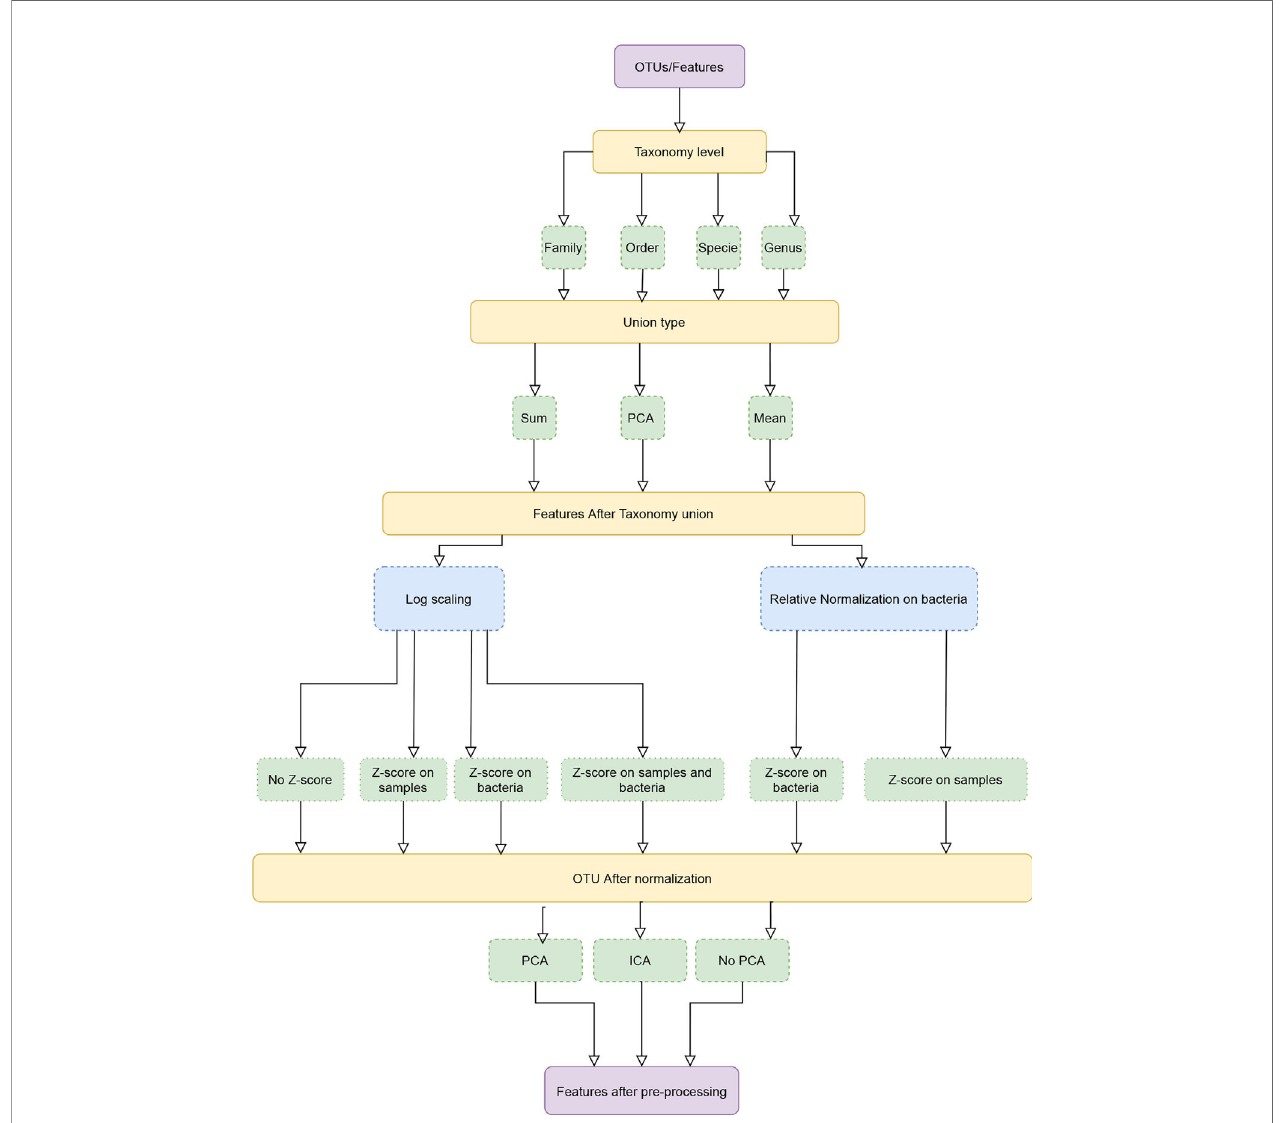
FIGURE 1 | Pipeline process diagram. The input is an OTU/ASV table and the appropriate taxonomy. The features are merged to a given taxonomic level. We tested three possible merging methods: Sum, Average and a PCA on each sub-group of features. Following the merging, we performed either a log scaling or a relative scaling. Following scaling, we performed z scoring on either bacteria or samples or both, and fi nally, we tested whether performing a dimension reduction on the resulting merged and normalized features improves the accuracy of